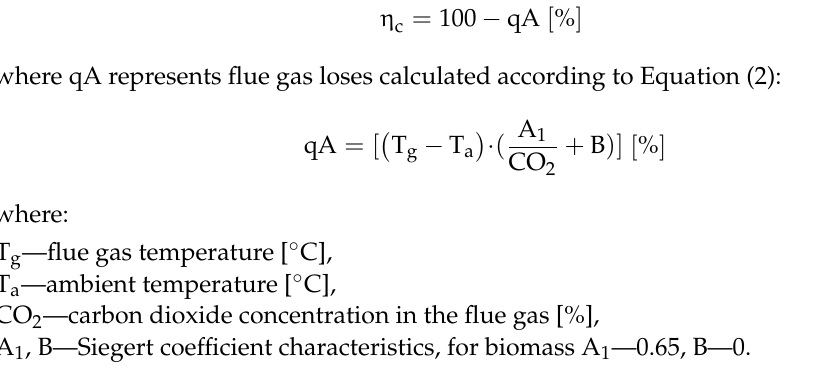
Figure 4. Control panel for the testing system.